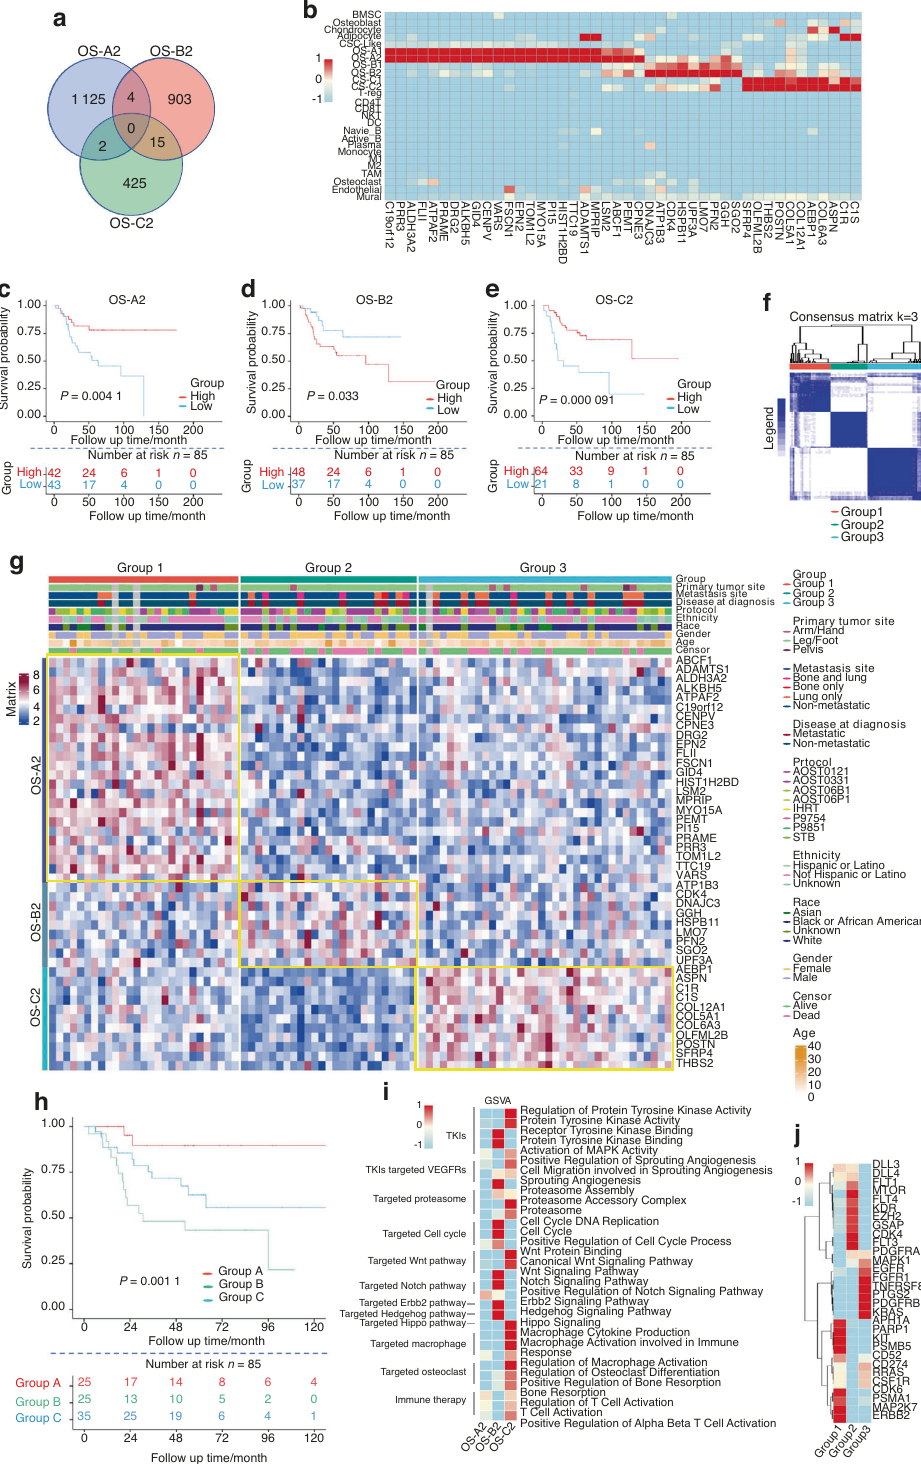
Fig. 4 Classi fi cation of OS samples from the TARGET dataset based on the markers of the three differentiation branches of OS cells. a Venn diagram showing the similarities and differences of the calculated markers of OS-A2/B2/C2 clusters. b Heatmap showing the expression of the 44 selected marker genes of OS-A2/B2/C2 in all 29 clusters. Kaplan – Meier curves of overall survival for patients with different expression levels of total OS-A2 ( c ), OS-B2 ( d ) or OS-C2 ( e ) markers in OS patients from the TARGET dataset. f Consensus clustering matrices with the 44 marker genes of OS-A2/B2/C2 in TARGET OS samples for k = 3. g Heatmap showing the expression of 44 marker genes in the three clustered groups of TARGET OS samples. h Kaplan – Meier curves of overall survival for the three clustered groups of TARGET OS patients. i Heatmap showing activation differences of pathways related to targeted therapies in the three subgroups of TARGET OS samples. j Heatmap showing expression levels of genes related to targeted therapies in the three subgroups of TARGET OS